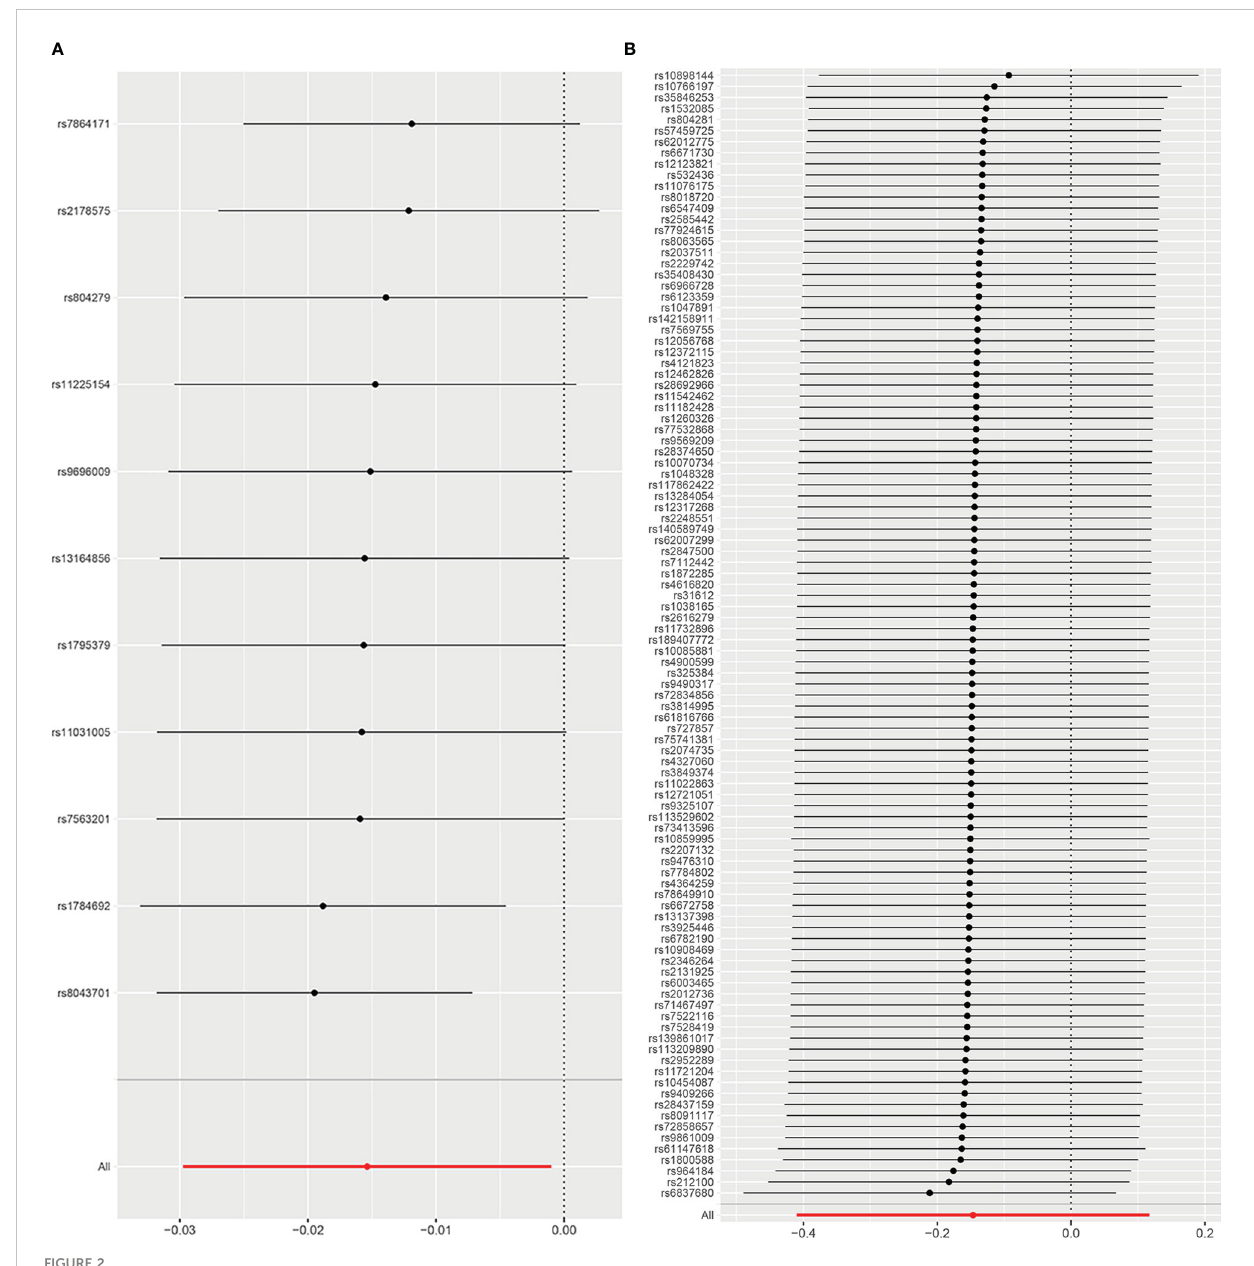
FIGURE 2 The leave-one-out analysis plot (A) Leave-one-out plot for PCOS on 25OHD. (B) Leave-one-out plot for 25OHD on